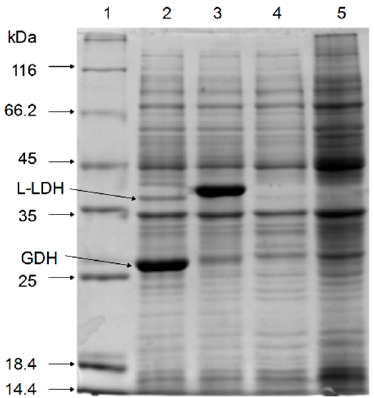
Figure 2. Validation of the expression of L -LDH and GDH in induced recombinant E. coli . Lane 1: protein marker; lane 2: E. coli pETDuet- ldhL-gdh ; lane 3: E. coli pETDuet- ldhL ; lane 4: E. coli pETDuet-1; lane 5: E. coli BL21 (DE3).